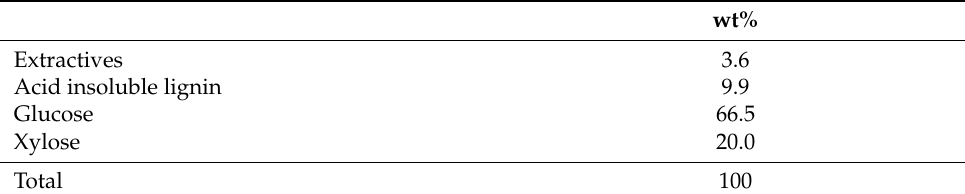
Table 3. ASB solids composition.